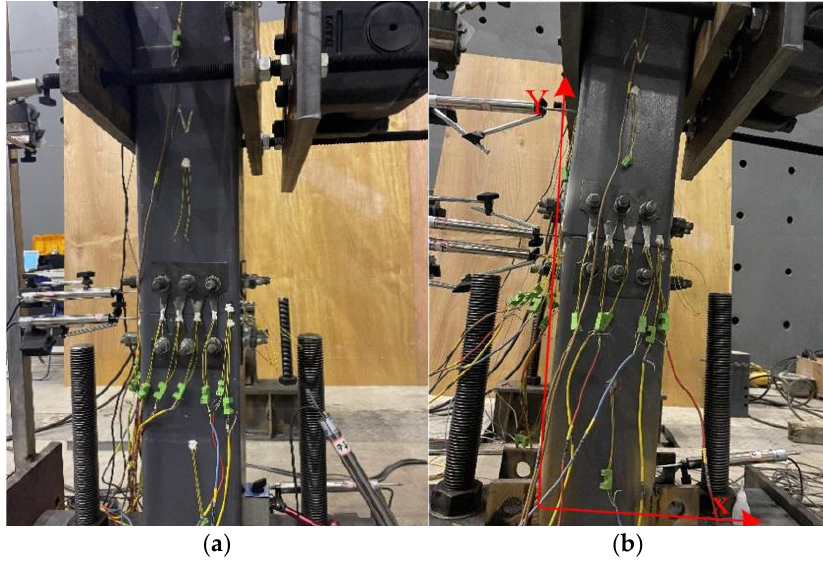
Figure 12. CFST-F loading diagram, ( a ) Before loading, ( b ) After loading.